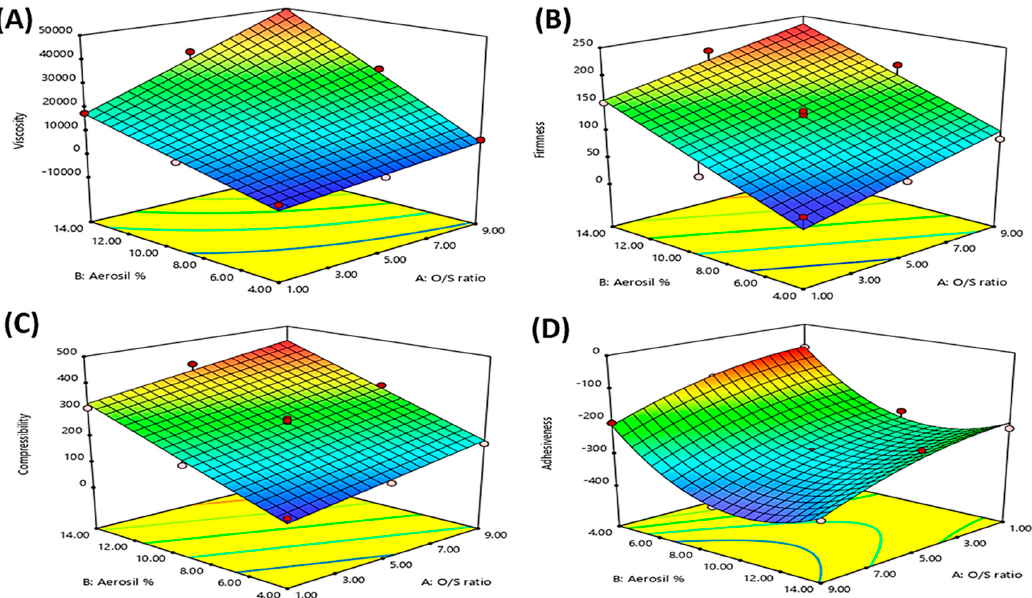
Figure 1. Response surface plots for the e ff ects of O/SAA ratio (X 1 ) and Aerosil % (X 2 ) on the viscosity ( A ), fi rmness ( B ), compressibility ( C ), and adhesiveness ( D ) of OLM oleogel formulations.